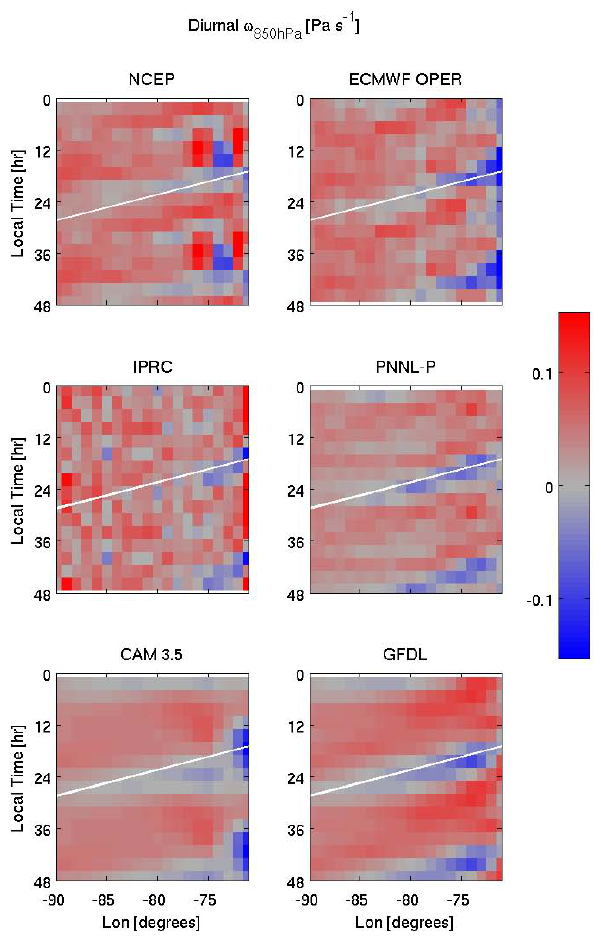
Fig. 12. Hovm¨uller diagram along 20 ◦ S of a 24-h composite (re- peated twice for clarity) of omega at 850hPa (Pas − 1 ) of selected models for October 2006. White line is phase speed of 30ms − 1 .